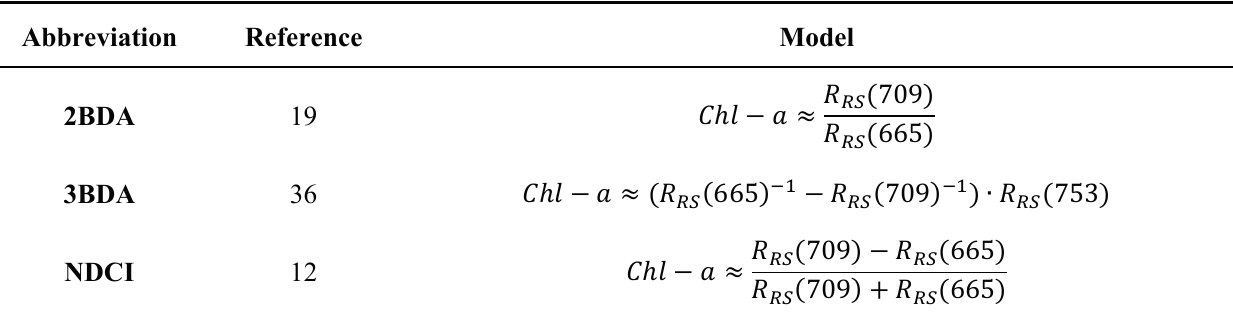
Table 2. Summary of R RS based bio-optical models to retrieve chl- a concentration. Where: Chl- a is the chlorophyll- a concentration; and R RS is the Remote Sensing Reflectance obtained by Equation (1) at specific